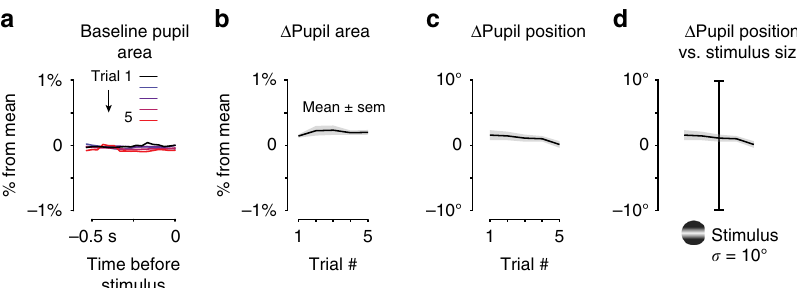
Fig. 2 Pupil dynamics do not explain behavioral improvements. a , b Average pupil area before stimulus onset does not change from fi rst to fi fth trial (0.03 ± 0.17% versus 0.04 ± 0.07%, p = 0.10). In total, 426 correct monocular detection blocks in 22 sessions. c In the same trials, pupil position before stimulus onset changes <2° (Trial 1, 1.6 ± 3.6° versus 0.14 ± 2.4°, relative to mean position across entire session; p = 0.02 , Wilcoxon signed-rank test). d Changes of pupil position (<2°) are an order of magnitude smaller than spatial extent of detected stimuli (grating, 2 σ = 20°).